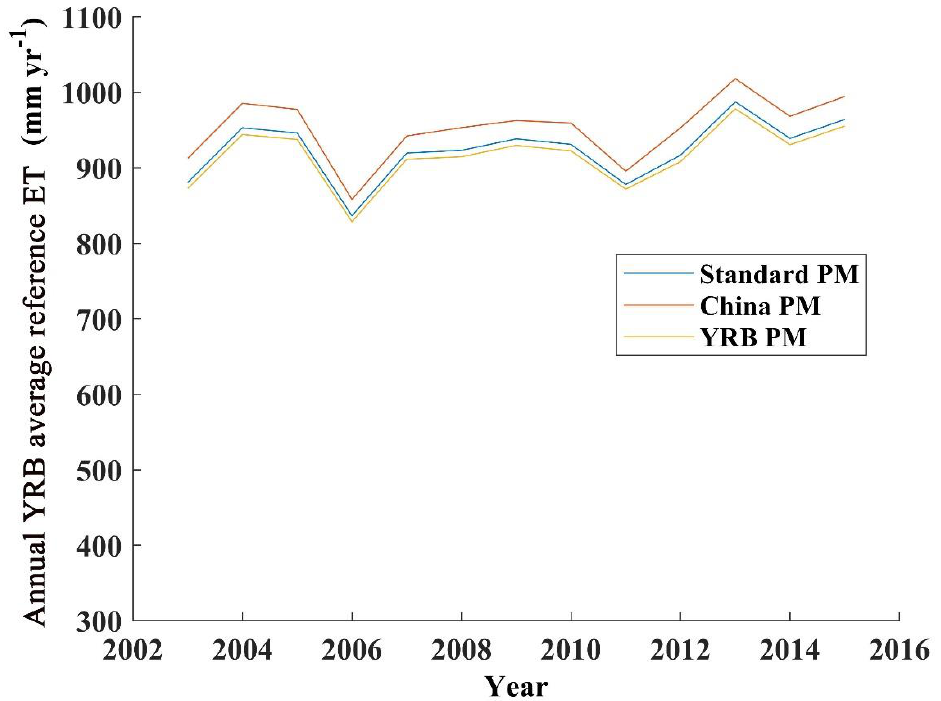
Figure A3. Differences among three annual YRB average reference ET products calculated suing three methods. China PM is the revised PM in China, YRB PM is the revised PM in the YRB, and standard PM is the original PM from Food and Agriculture Organization Irrigation and Drainage Paper No. 56 [50].